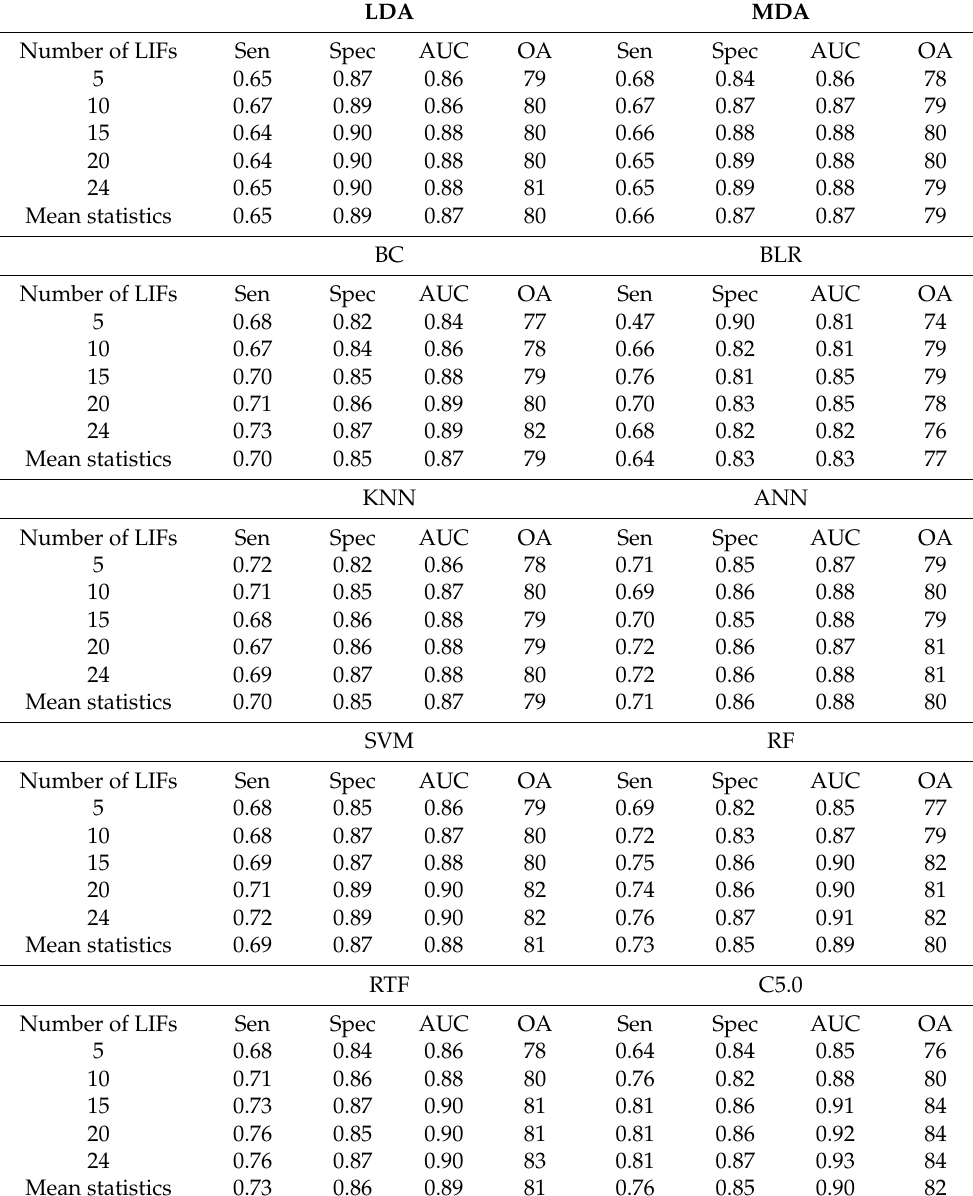
Table 5. Accuracy statistics of ML models using different sets of